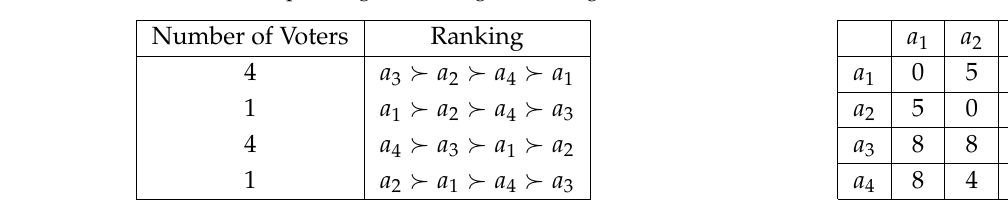
Table 1. Profile of rankings π 4 given by ten voters on the set of four alternatives A = { a 1 , a 2 , a 3 , a 4 } 10 (left) and corresponding outranking matrix